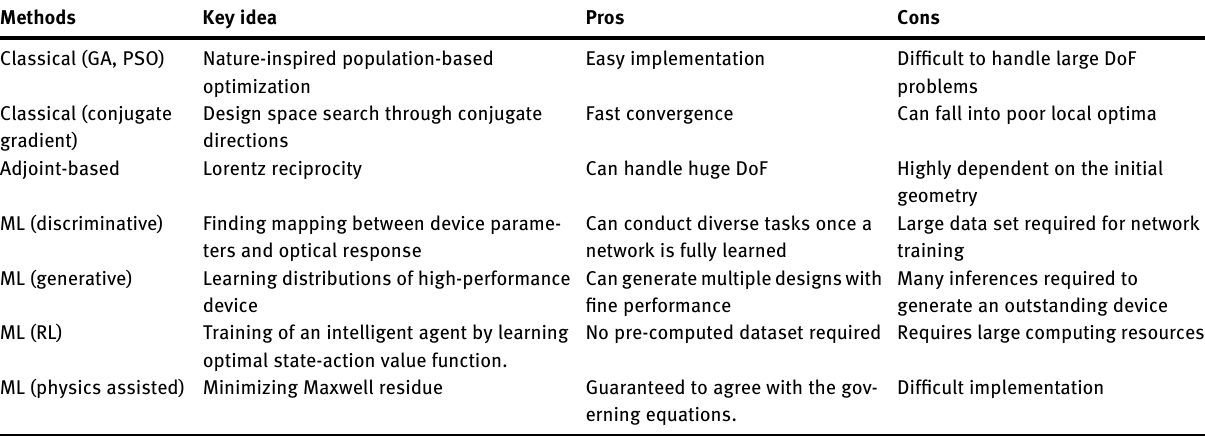
Figure 1: Comparison between conventional (left) and free-form (right) design schemes. In conventional design methods, photonic devices are composed of elements with fixed primitive shapes parameterized by a small number of variables. In contrast, a free- form design scheme allows for non-trivial shapes and topology modifications, exploring a much larger portion of the design space.